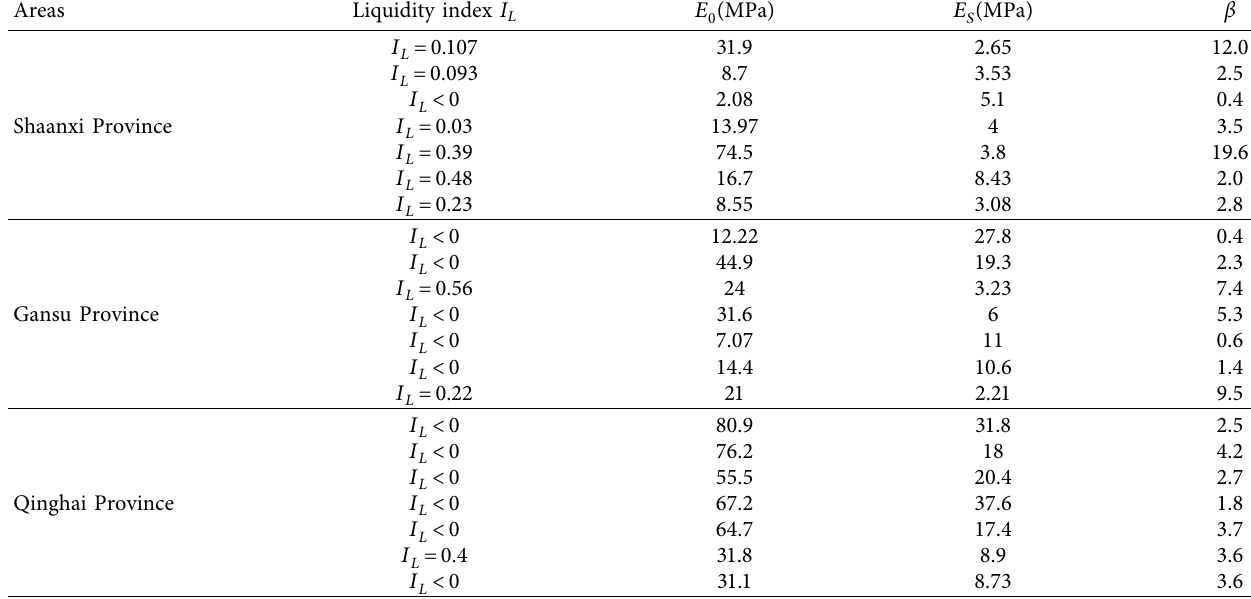
Table 1: Empirical values of E 0, Es , and β for